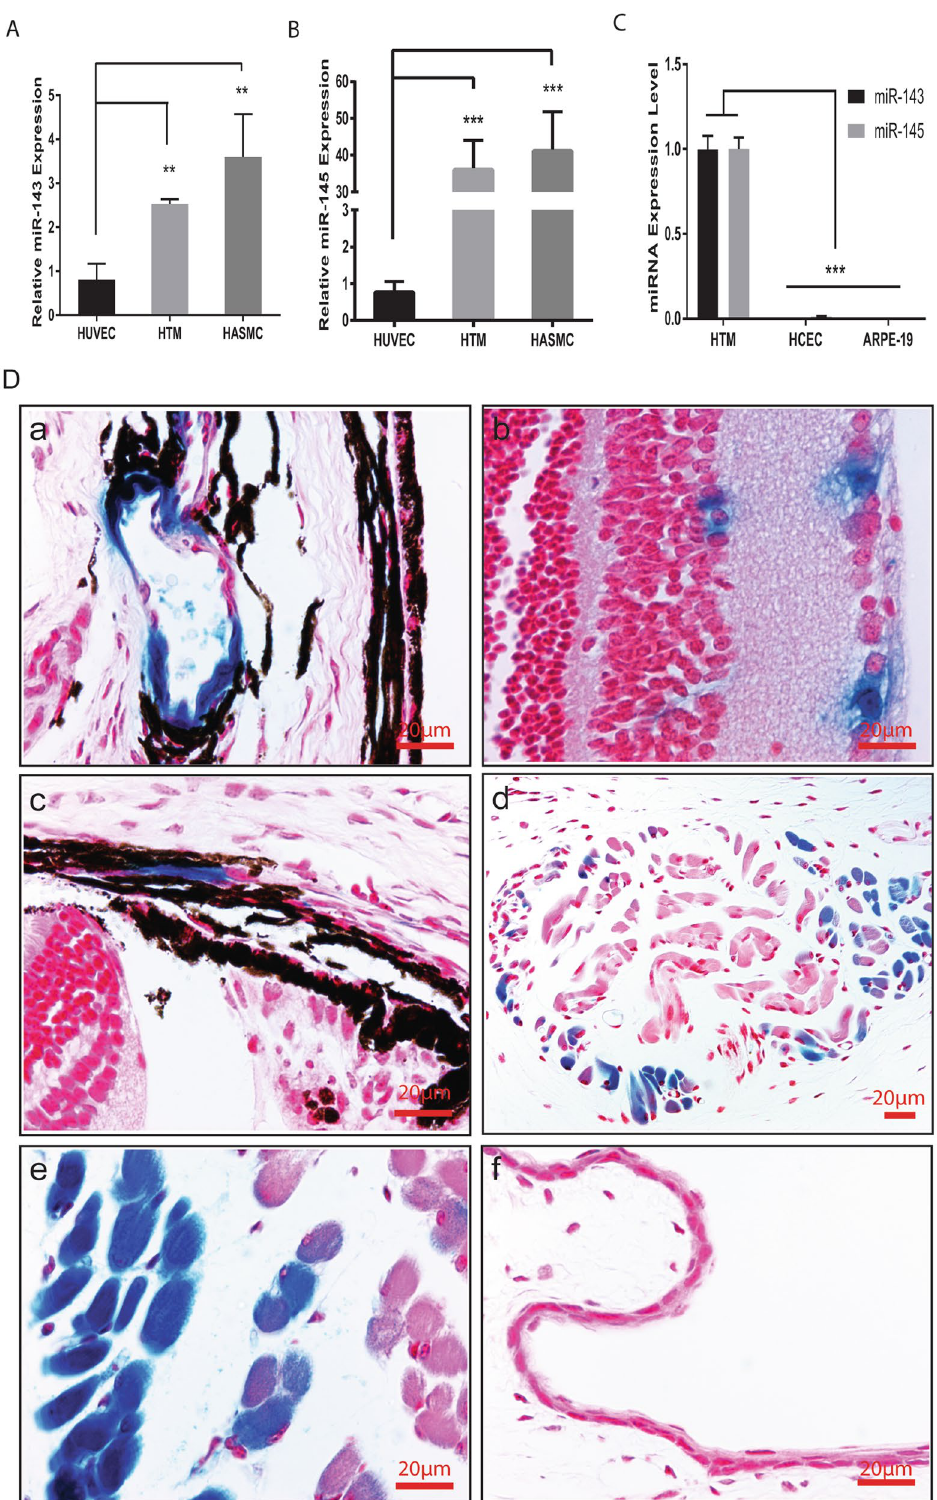
Figure 1. Expression of miR-143 and miR-145 in the eye as revealed by qRT-PCR and LacZ staining. LacZ plus eosin counter-staining was performed in ~2-month old transgenic mice in which LacZ is driven by a 5 kb miR-143/145 enhancer. ( A ) Relative expression of miR-143 in HTM cells compared to HUVEC and HASMC cells. ** p < 0.01; ( B ) Relative expression of miR-145 in HTM cells compared to HUVEC and HASMC cells. *** p < 0.001; ( C ) Relative expression of miR-143/145 in HTM cells compared to HCEC and ARPE-19 cells. *** p < 0.001; ( D ) LacZ staining was observed in smooth muscle (a), pericytes (b), ciliary muscle (c), extraocular muscle (d,e), but not in the corneal epithelial layer (f) in the